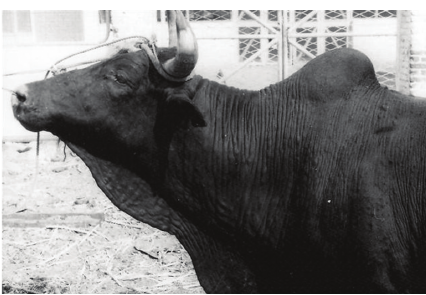
Figure 2: Pustules and crust-covered lesions of demodectic mange involving extensive areas of the body of a heifer. Note marked wrinkling and folding of the skin.